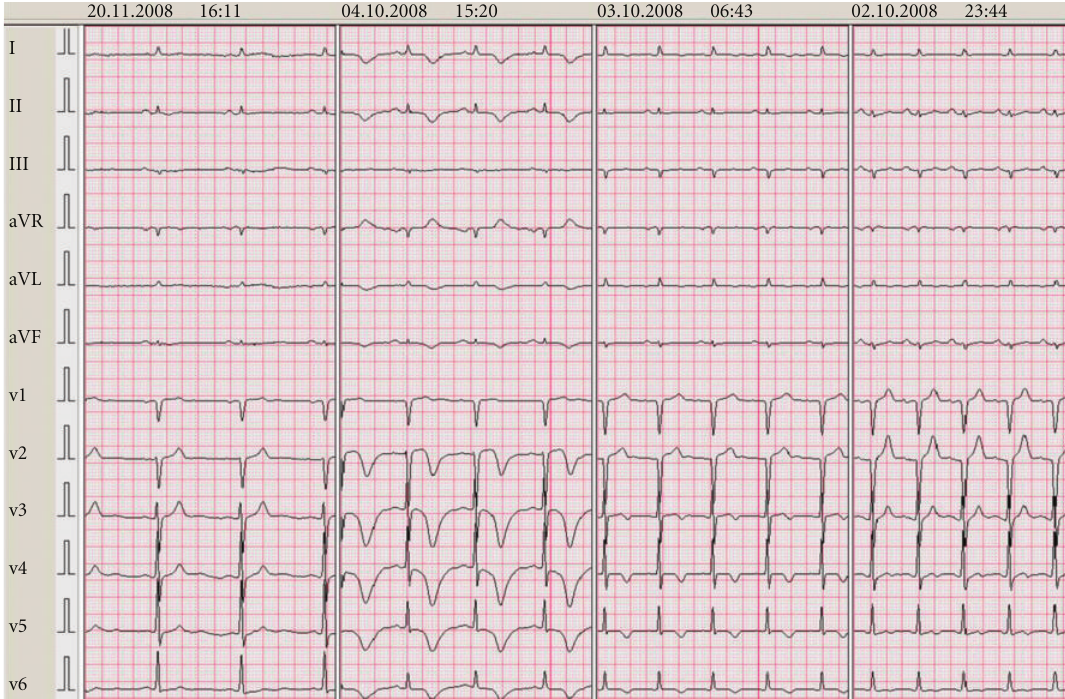
Figure 4: Case 3 (EKGs shown chronologically from right to